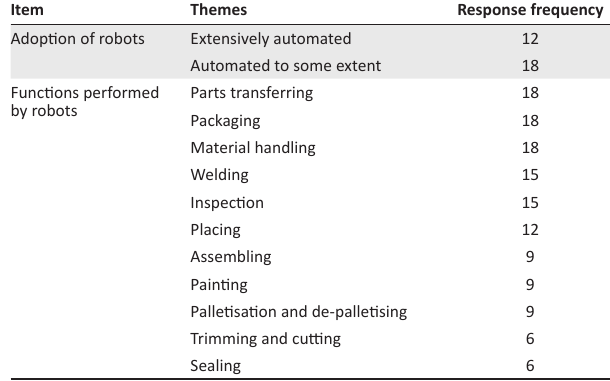
TABLE 2: Extent of robot adoption and main functions of